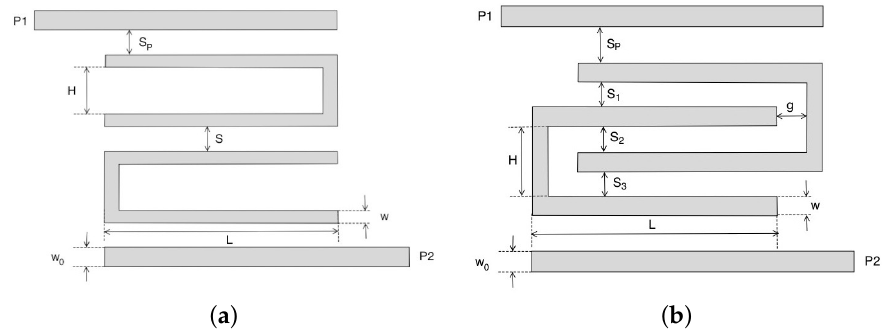
Figure 1. Problem geometries: ( a ) standard hairpin filter, ( b ) pseudo interdigitated hairpin